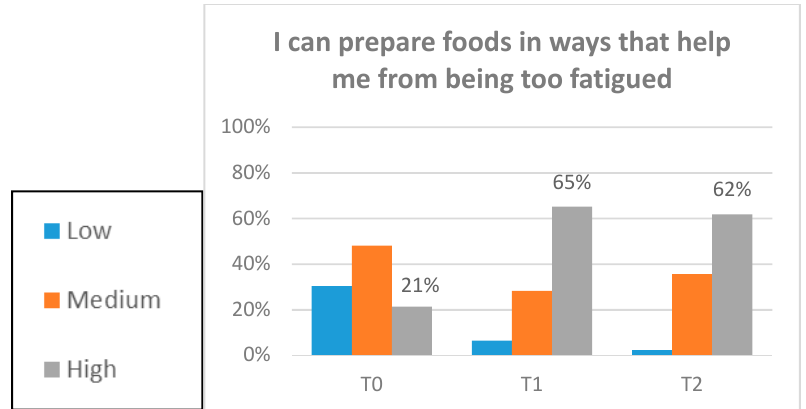
Figure 3. Confidence items. Participants completed the baseline assessment (T0). Participants completed the post-intervention assessment (T1). Participants completed the three-month post-intervention assessment (T2).